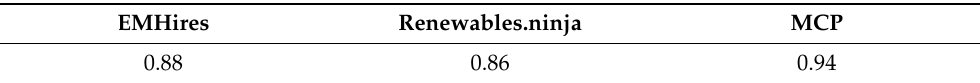
Table 1. Correlation value for different publicly available datasets and the national aggregated wind power production—January 2014 to December